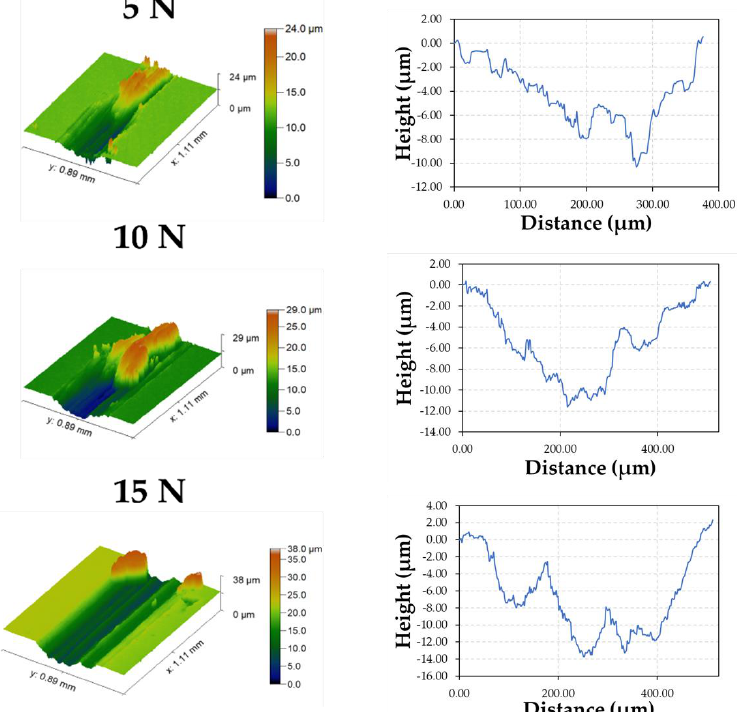
Figure 15. The wear tracks of the Zr-coated specimen S1 under the normal loads of 5, 10, and 15 N.